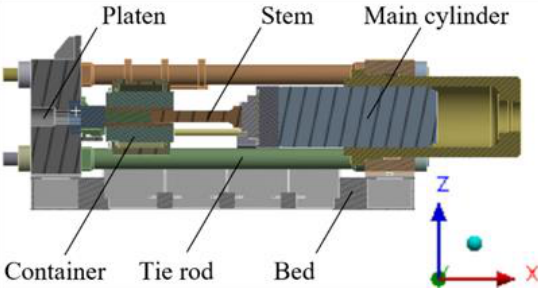
Figure 1. Components of an extruder.